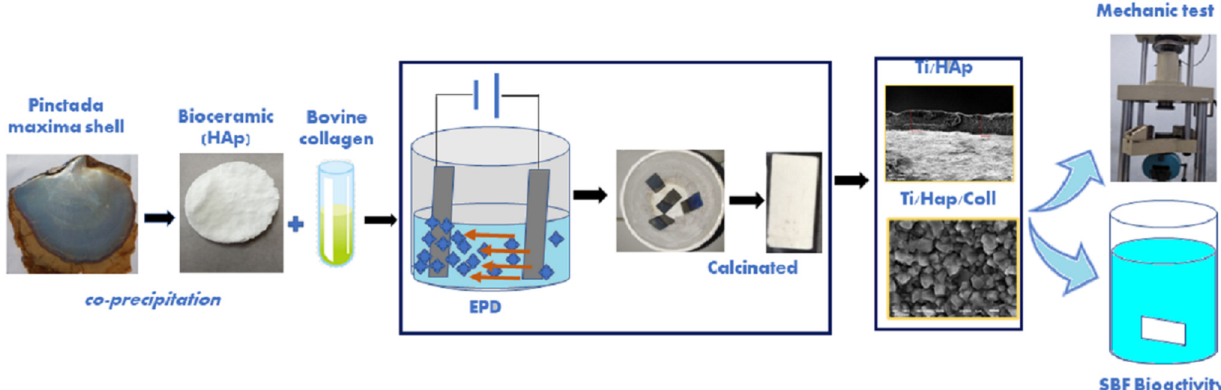
Figure 1. Schematic procedures of coated titanium substrate using HAp/Coll with the mechanical and bioactivity assay.